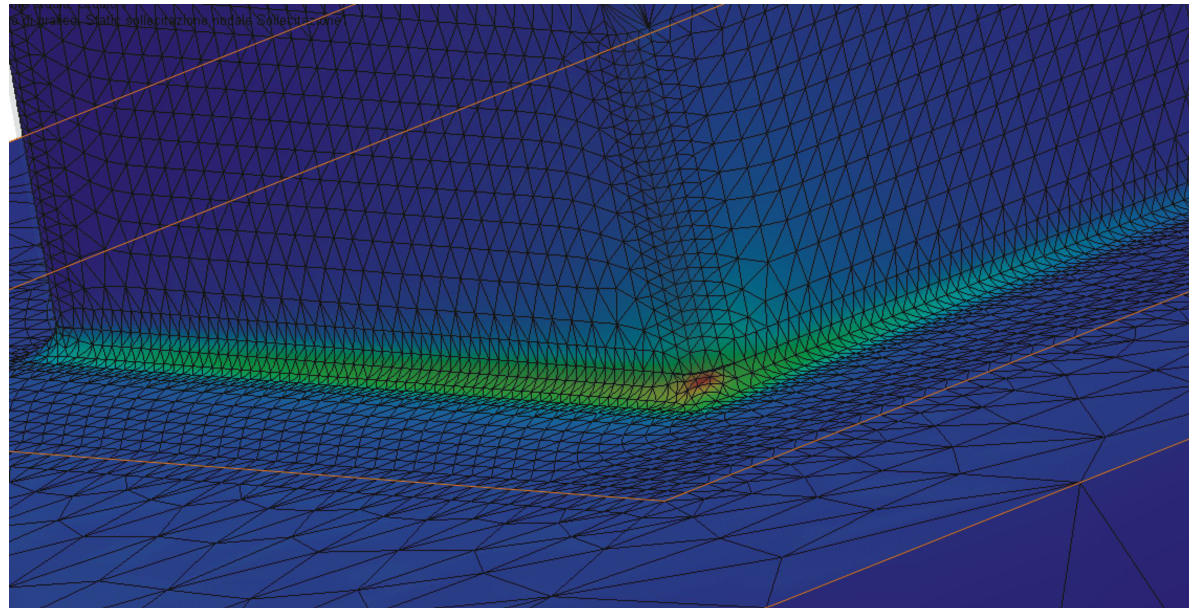
Figure 19: Stress concentration in the polar expansion and base